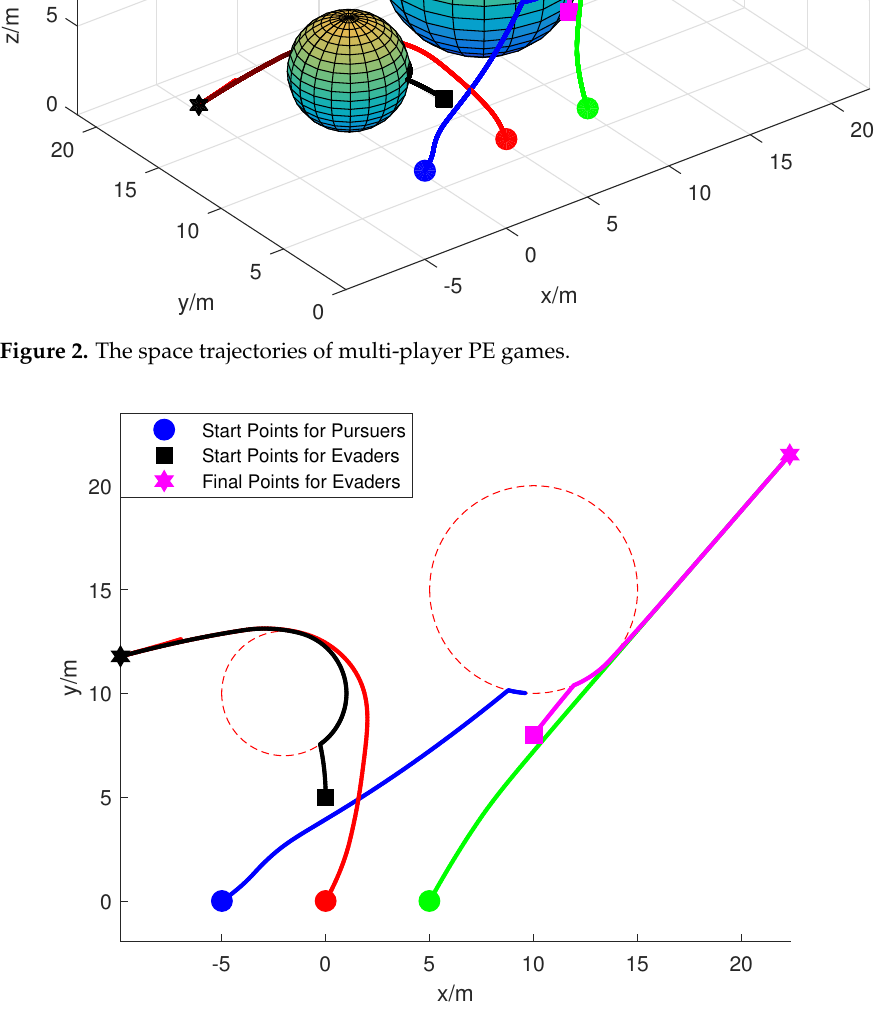
Figure 3. All trajectories in the horizontal plane. The blue, red and green lines are plane trajectories of 1st, 2nd and 3rd Pursuer, respectively. The black and magenta lines are plane trajectories of 1st and 2nd Evader,